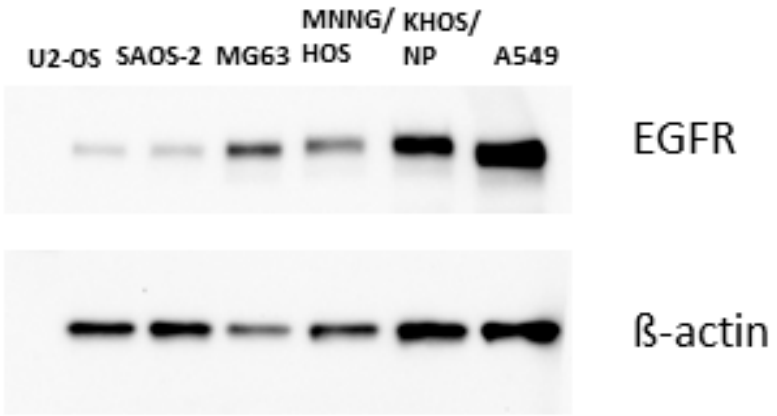
Figure A1. Western blot of EGFR expression in osteosarcoma cell lines. β -actin was used as internal control, and the overexpression of EGFR in the lung cancer cell line, A549, was introduced as positive control.